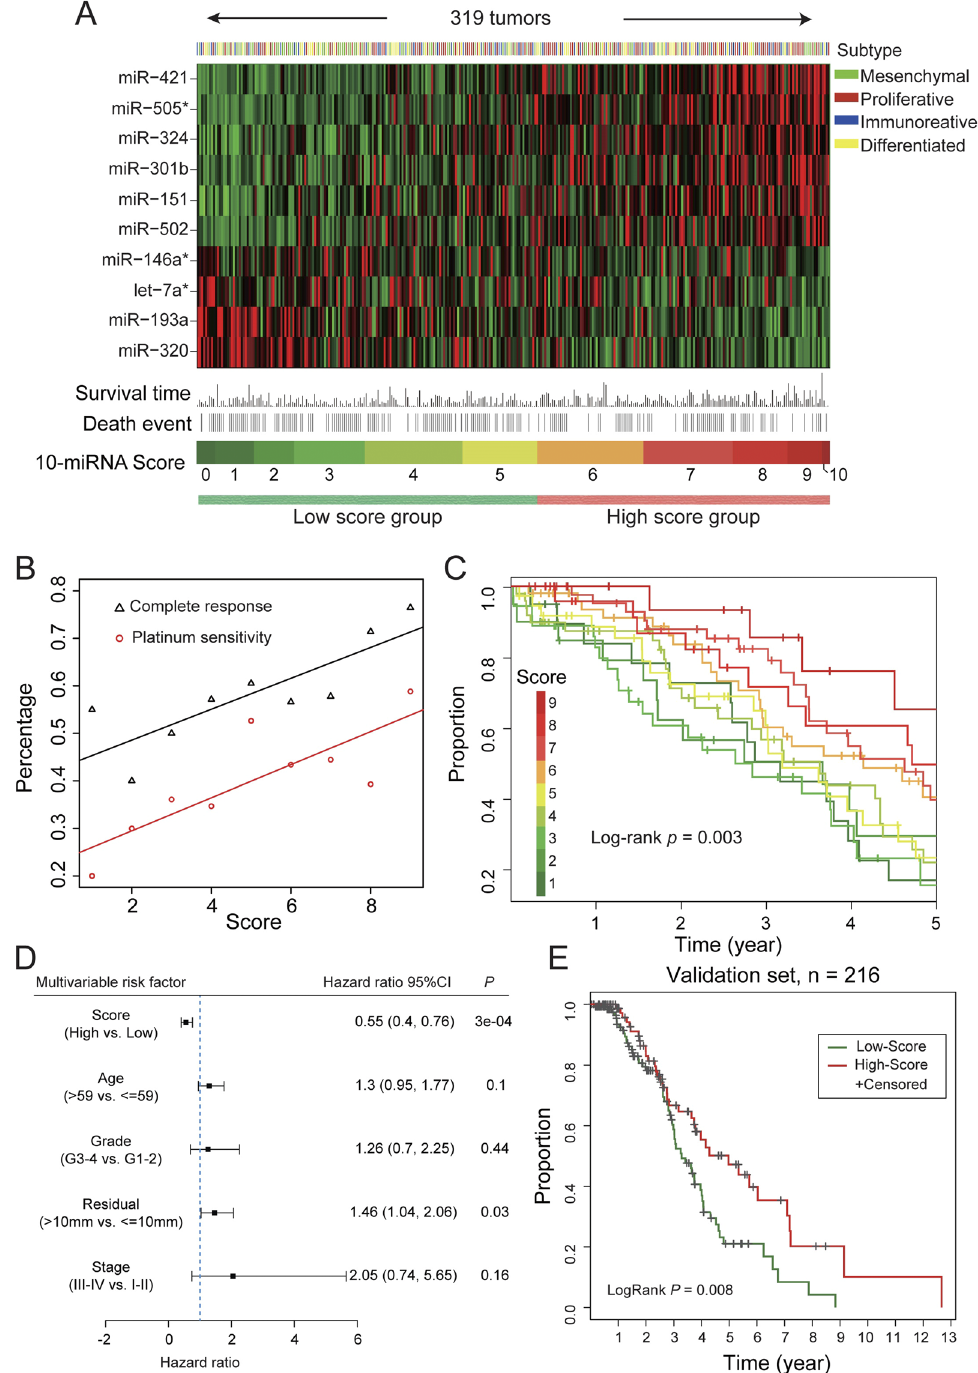
Figure 4. The 10-miRNA-score predicts the outcome of ovarian cancer patients treated with platinum agents. ( A ) Heatmap of the expression of the 10 miRNAs and the association with clinical information, miRNA-score and molecular subtypes for 319 TCGA ovarian cancer patients. Tumours are ordered by the 10-miRNA-score. ( B ) The percentage of platinum-sensitive patients and percentage of patients achieving CR are associated with the increasing miRNA-score. ( C ) Improved survival is significantly associated with increasing 10-miRNA- score. ( D ) Multivariable Cox proportional hazards regression analysis of the 10-miRNA-score and the clinical parameters including age, FIGO stage, histological grade and size of surgical debulking. 10-miRNA-score is treated as a categorical variable (high vs. low). ( E ) Validation of the association between the 10-miRNA-score and survival using 216 independent TCGA ovarian cancer patients treated with platinum agents. These patients are not provided with level 3 mutation data but are provided with miRNA expression and outcome